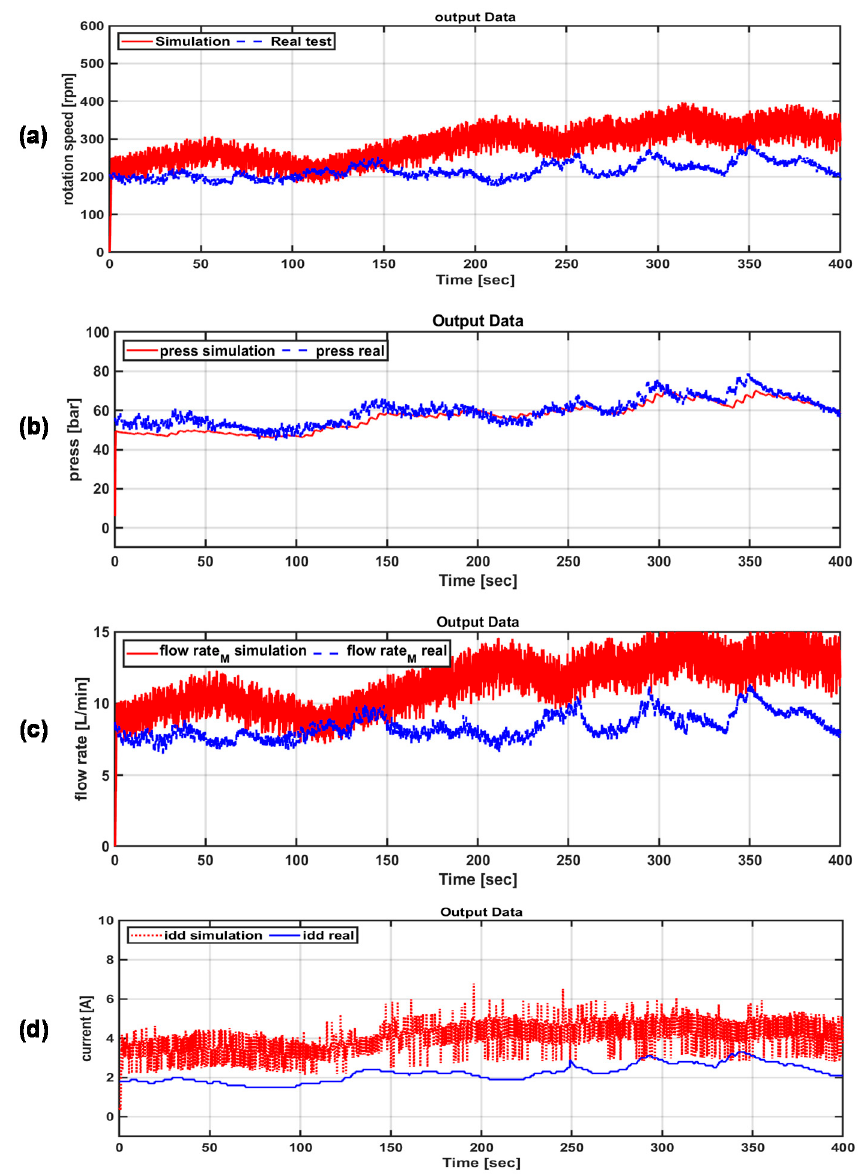
Figure 28. Comparison of PTO system characteristics according to real sea test results and P&O algorithm-based speed control algorithm of the simulator. ( a ) rotation speed; ( b ) mechanical pressure; ( c ) flow rate; ( d ) electrical load current.